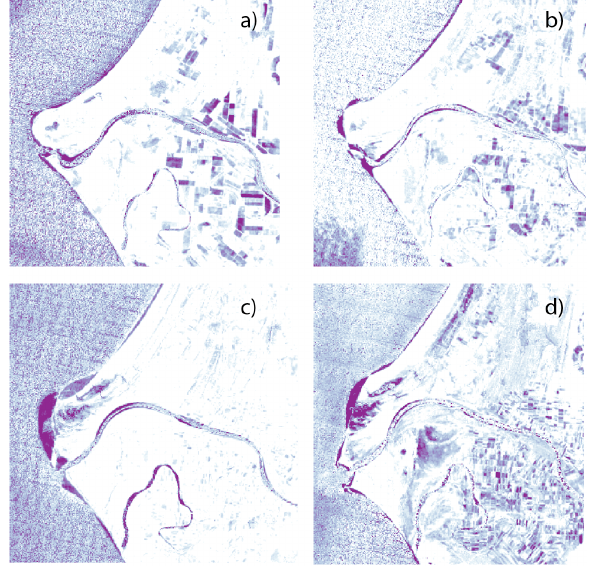
Figure 2. Changes of the coastal erosion through time in delta of Vjosa River. The greater the change, the darker the representation on the image. The Figure presents changes between years a) 1984-1990, b) 1991-2000, c) 2001-2010 and d) 2011-2015.